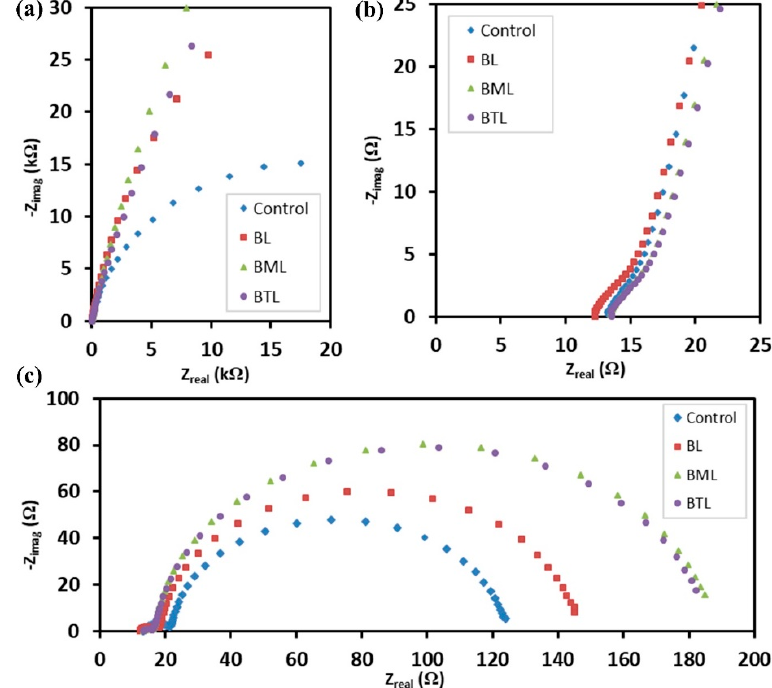
Figure 8. Nyquist plot of fabricated DSSC integrated with and without nanocrystalline TiO 2 layer at ( a ) and ( b ) 0.30 V and ( c ) 0.65 V in the frequency range of 300 kH to 0.1 Hz. Table 1. Electrochemical properties of DSSC fabricated without (control sample) and with nanocrystalline TiO 2 layer.